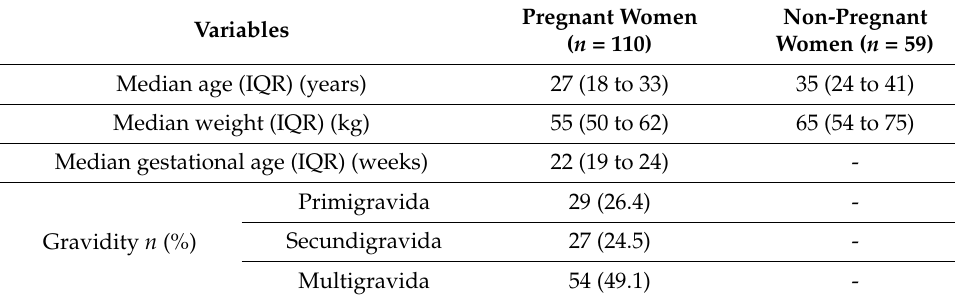
Table 1. Baseline characteristics of the study participants.